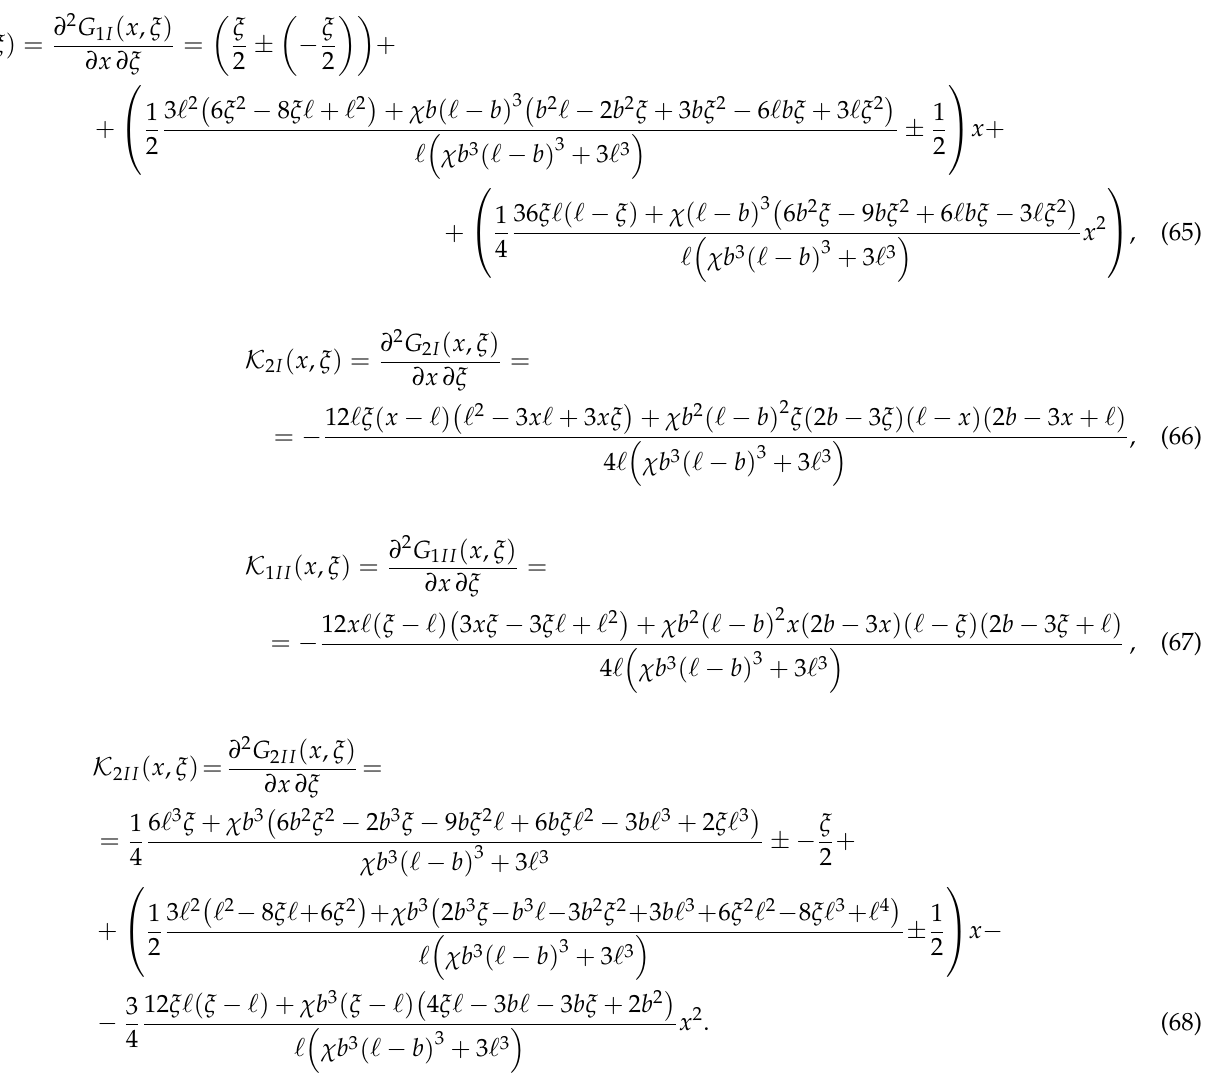
Figure 5 represents the kernel function of an FssF beam for various values of χ if ˆ b = L /2 and ξ =